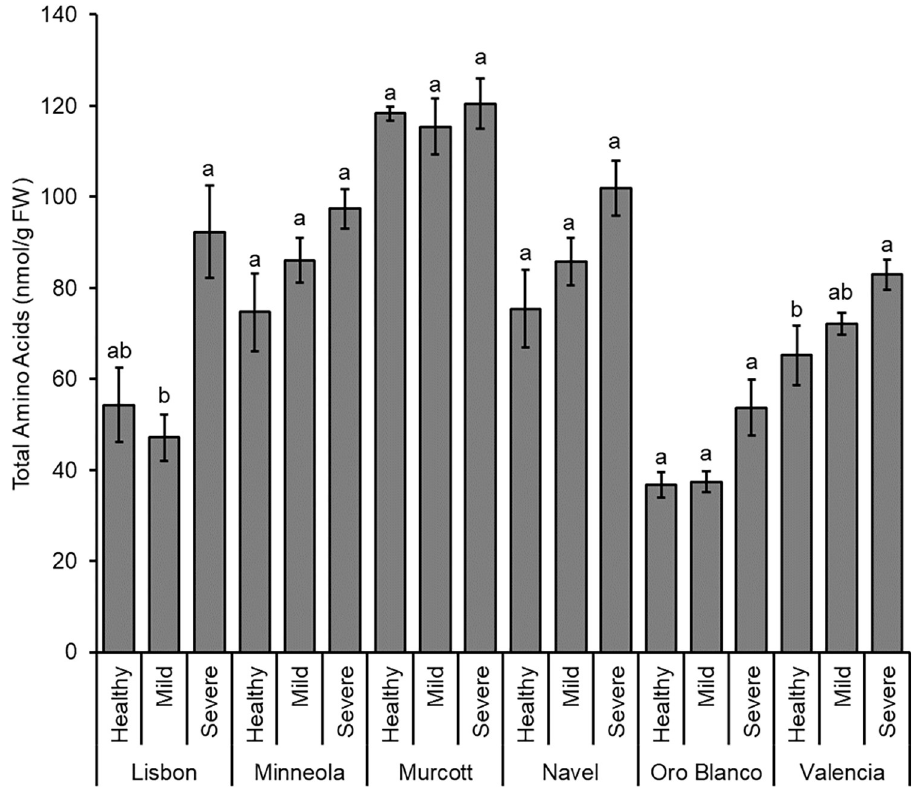
Fig 7. Summed total of all amino acid compounds. Mean of total amino acid levels ( ± SE) for each citrus cultivar that was health, CTV-mild strain infected, or CTV-severe strain infected. Different letters represent significantly different means by Tukey HSD tests for each citrus species